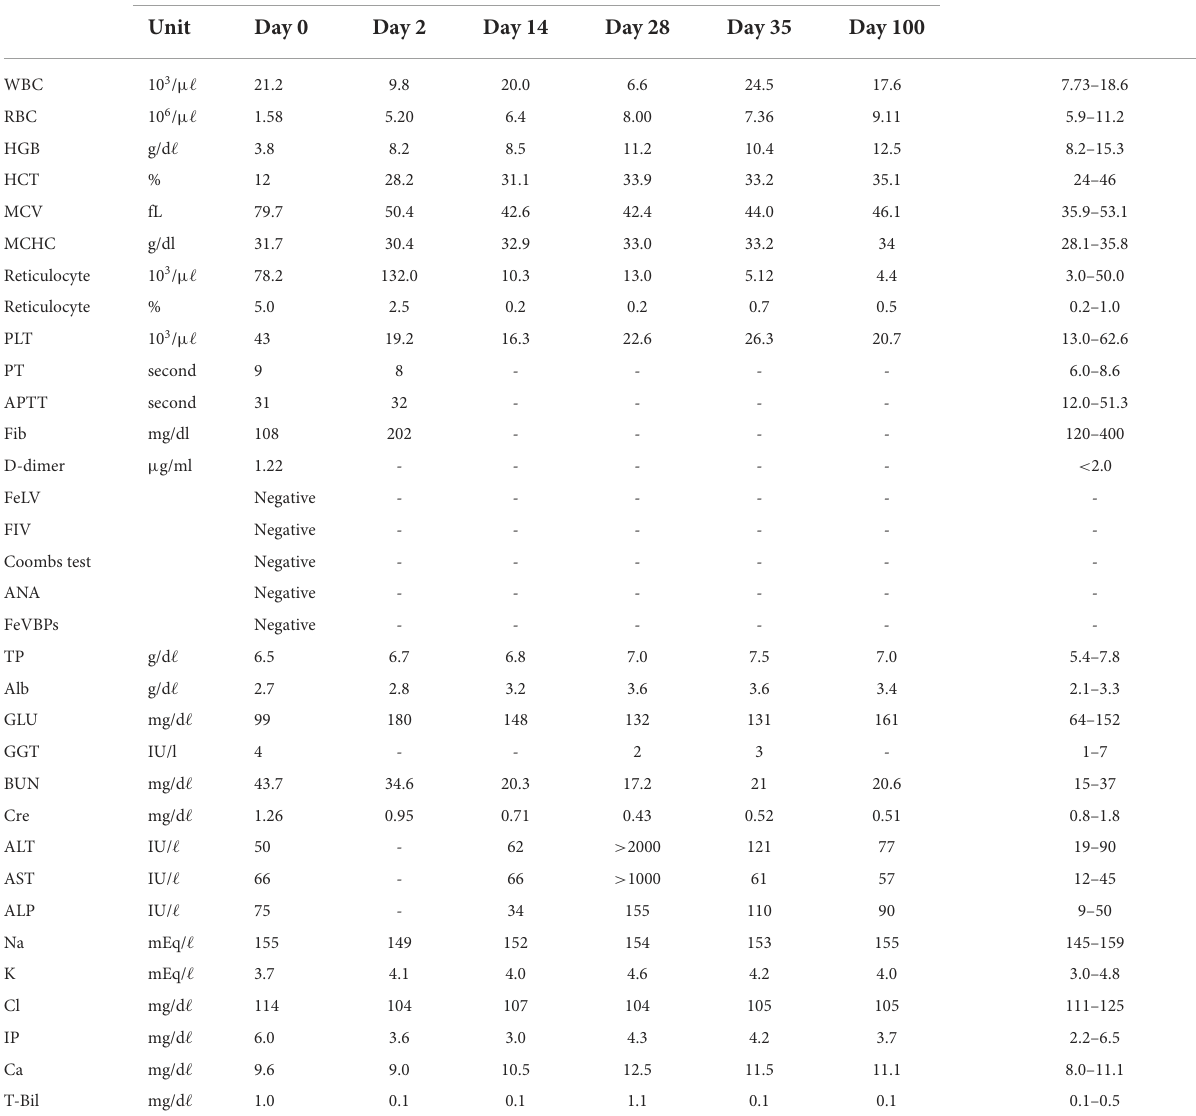
TABLE 1 Hematological and biochemical analysis in a cat with immune-mediated hemolytic anemia.